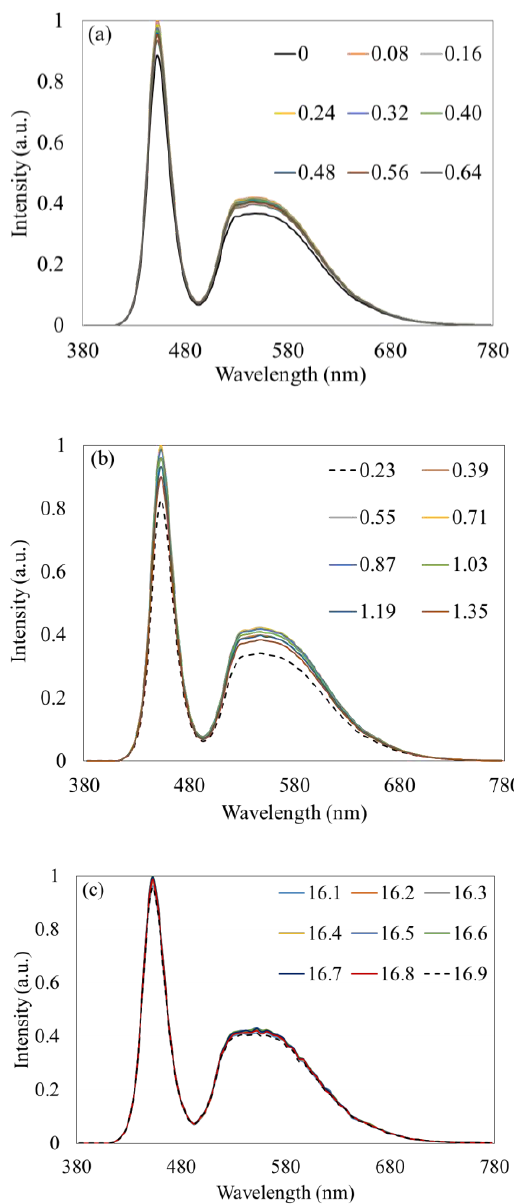
Fig. 3: Emission spectra of dual-layer phosphors: (a) Figure 3 : Emission spectra of dual-layer phosphors: (a) case of d 1 ; (b) case of d 2 and (c) case of r case of d ; (b) case of d and (c) case of r 1 2 2